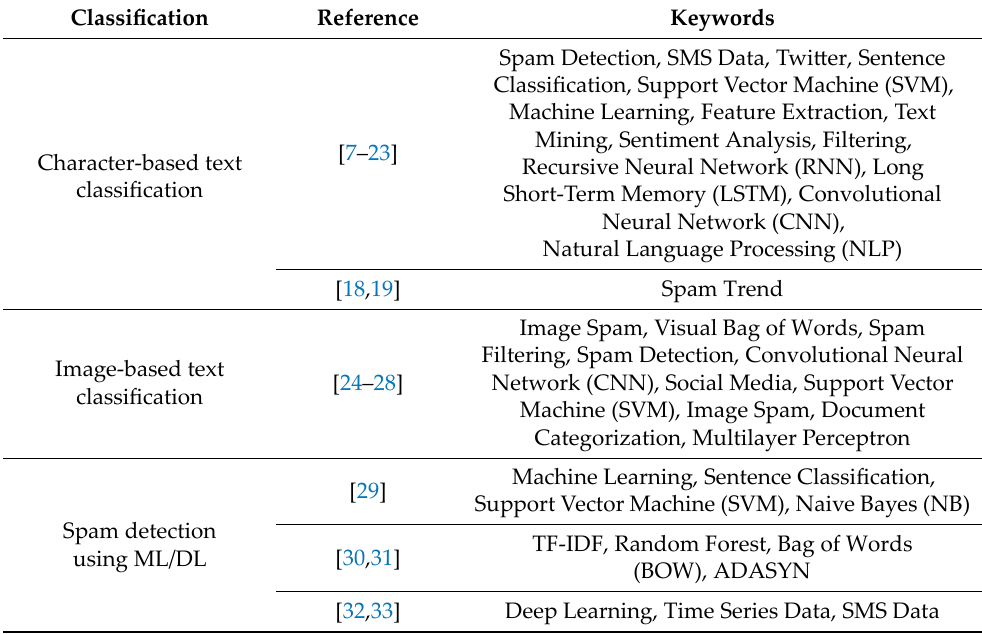
Table 1. Summary of related